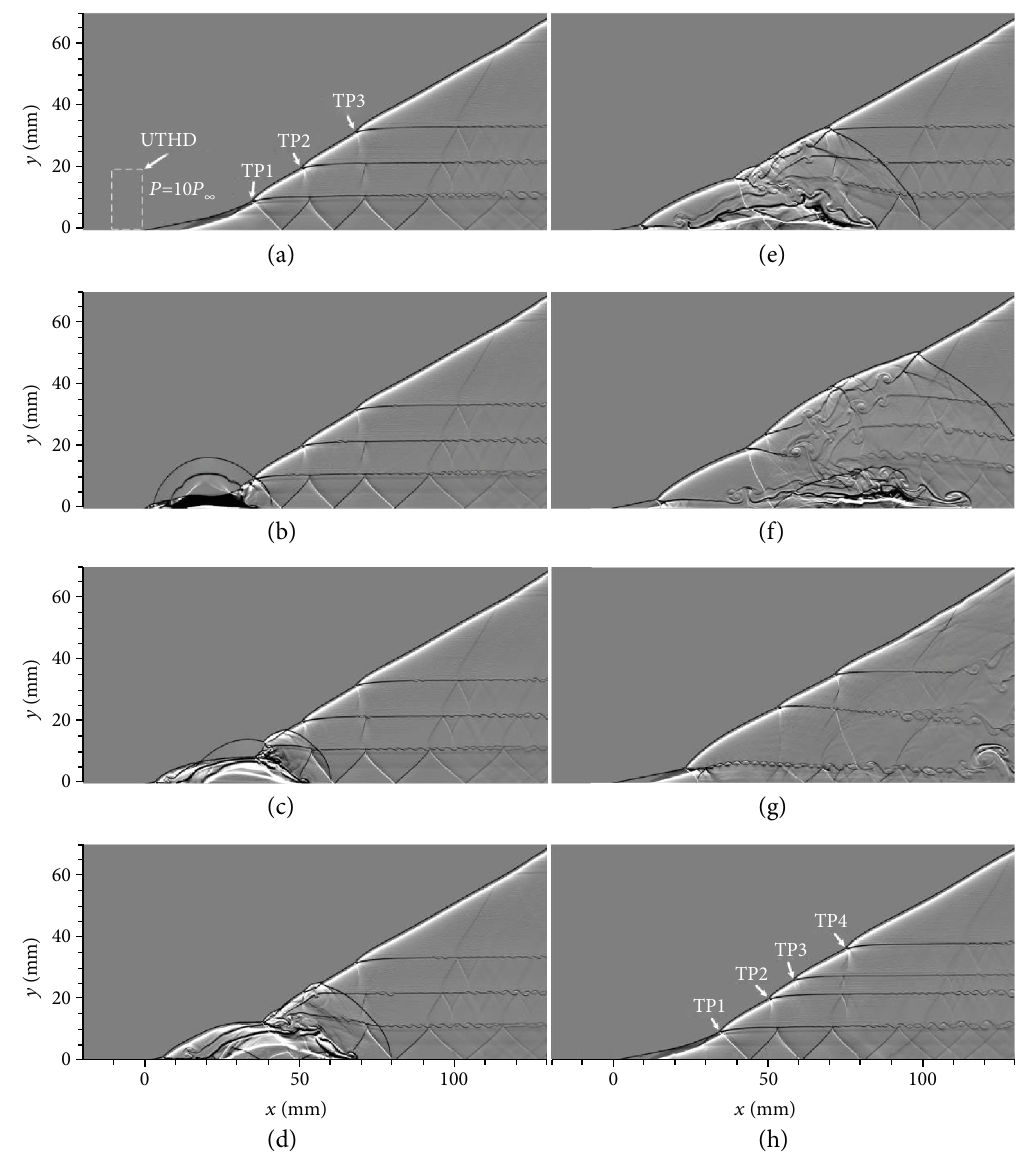
Figure 2: Evolution of the fl ow fi eld after UTHD at θ = 32 ∘ . (a) t = 0 (the disturbance has just been introduced into the fl ow fi eld), (b) t = 200 Δ t , (c) t = 300 Δ t , (d) t = 400 Δ t , (e) t = 500 Δ t , (f) t = 700 Δ t , (g) t = 1500 Δ t , and (h) steady state after the